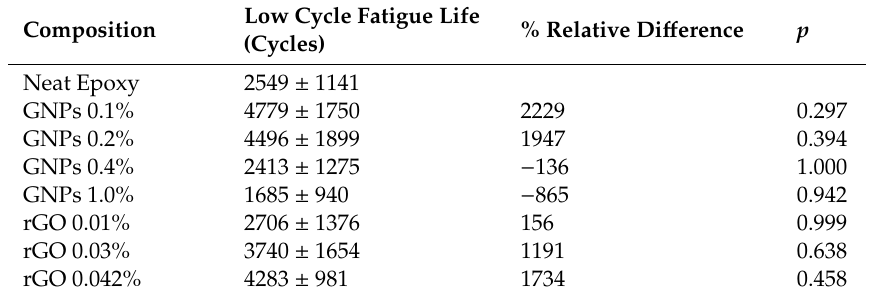
Table 3. Load capacity of the developed samples and results of Tukey post-hoc comparisons ( p -value) a .